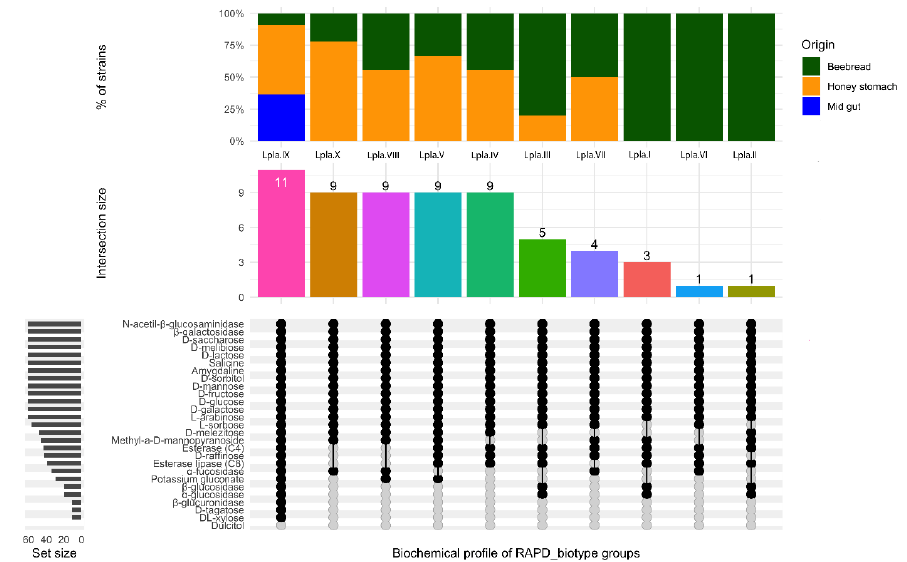
Figure 7. Upset plot regarding the biochemical profile of the 10 RAPD_biotype groups belonging to Lactiplantibacillus plantarum . Vertical barplot indicates the number of overlapping strains (intersection size) for each intersection represented by the connected dots. The intersection matrix is sorted in descending order. The grey horizontal barplots, reported as “Set size”, indicate the number of strains showing enzymatic activity. Microorganisms 2020 , 8 , x FOR PEER REVIEW